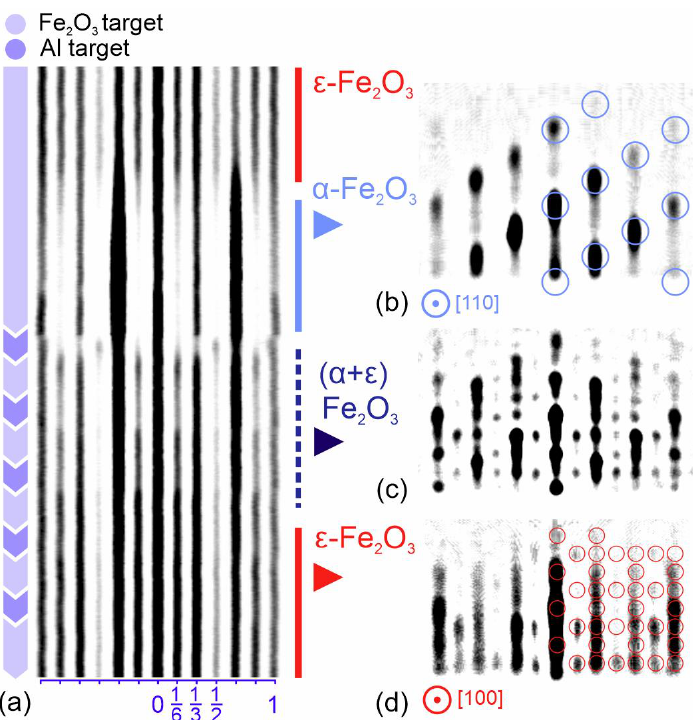
Figure 4. Time-dependent RHEED profile map ( a ) showing orthorhombic–trigonal–orthorhombic transformation. The map height corresponds to deposition of about 100 Å of Fe 2 O 3 . The epsilon-to- alpha transformation occurs in absence of aluminum while the reverse alpha-to-epsilon transforma- tion takes place via 1:10 aluminum substitution carried out by consecutive ablation of Fe 2 O 3 and Al targets. The RHEED pattern gradually changes during the reverse transformation from trigonal ( b ), to mixed trigonal-orthorhombic ( c ), and finally to pure orthorhombic ( d ).